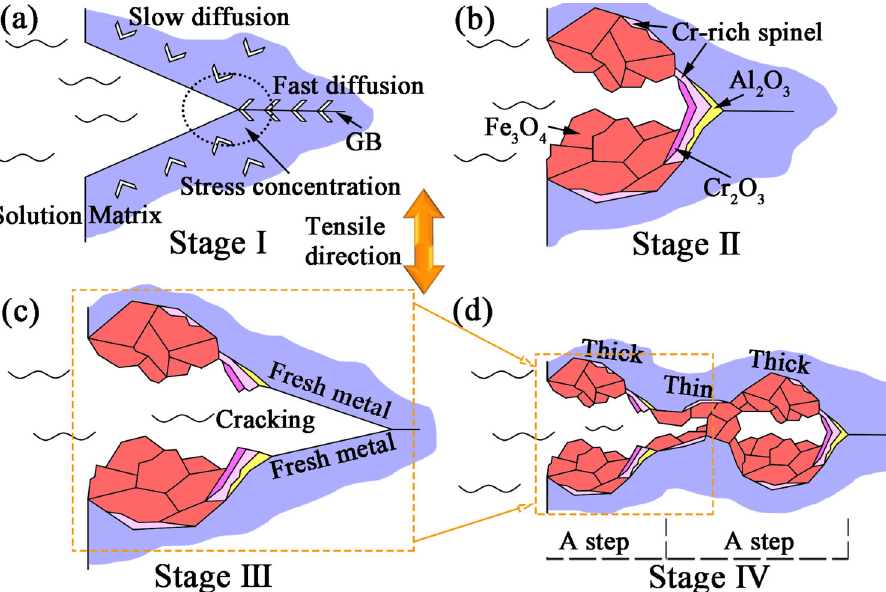
Fig. 14 Schematic crack growth process of AFA steel exposed to sCO 2 . ( a ) the original state and the diffusion of elements at different positions at the crack tip, ( b ) the formation of the oxide scale at the crack tip, ( c ) the fracture of the oxide scale and the growth of the crack, ( d ) the formation of oxide scale on the fresh surface.